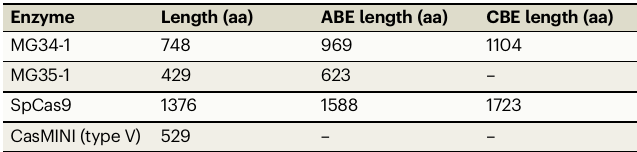
Table 1 | Nucleases and base editor amino acid length vs. reference SpCas9 Enzyme Length